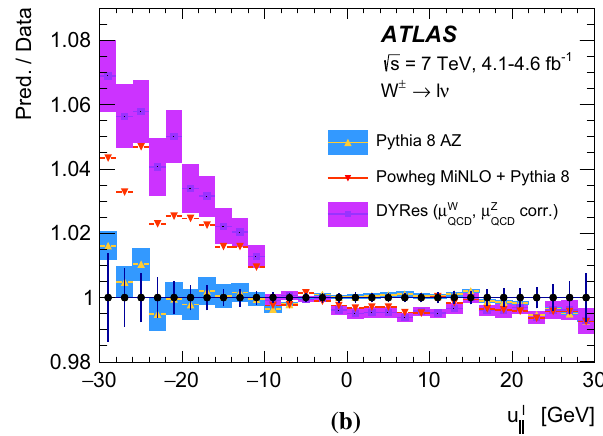
the Pythia 8 AZ prediction reflects the uncertainty in the p W distri- T (cid:7) bution. The uncertainty band around the DYRes prediction assumes T and b u (cid:5) dis- that uncertainties induced by variations of the QCD scales μ F , μ R and μ μ Res , collectively referred to as QCD , are fully correlated in W and Z production